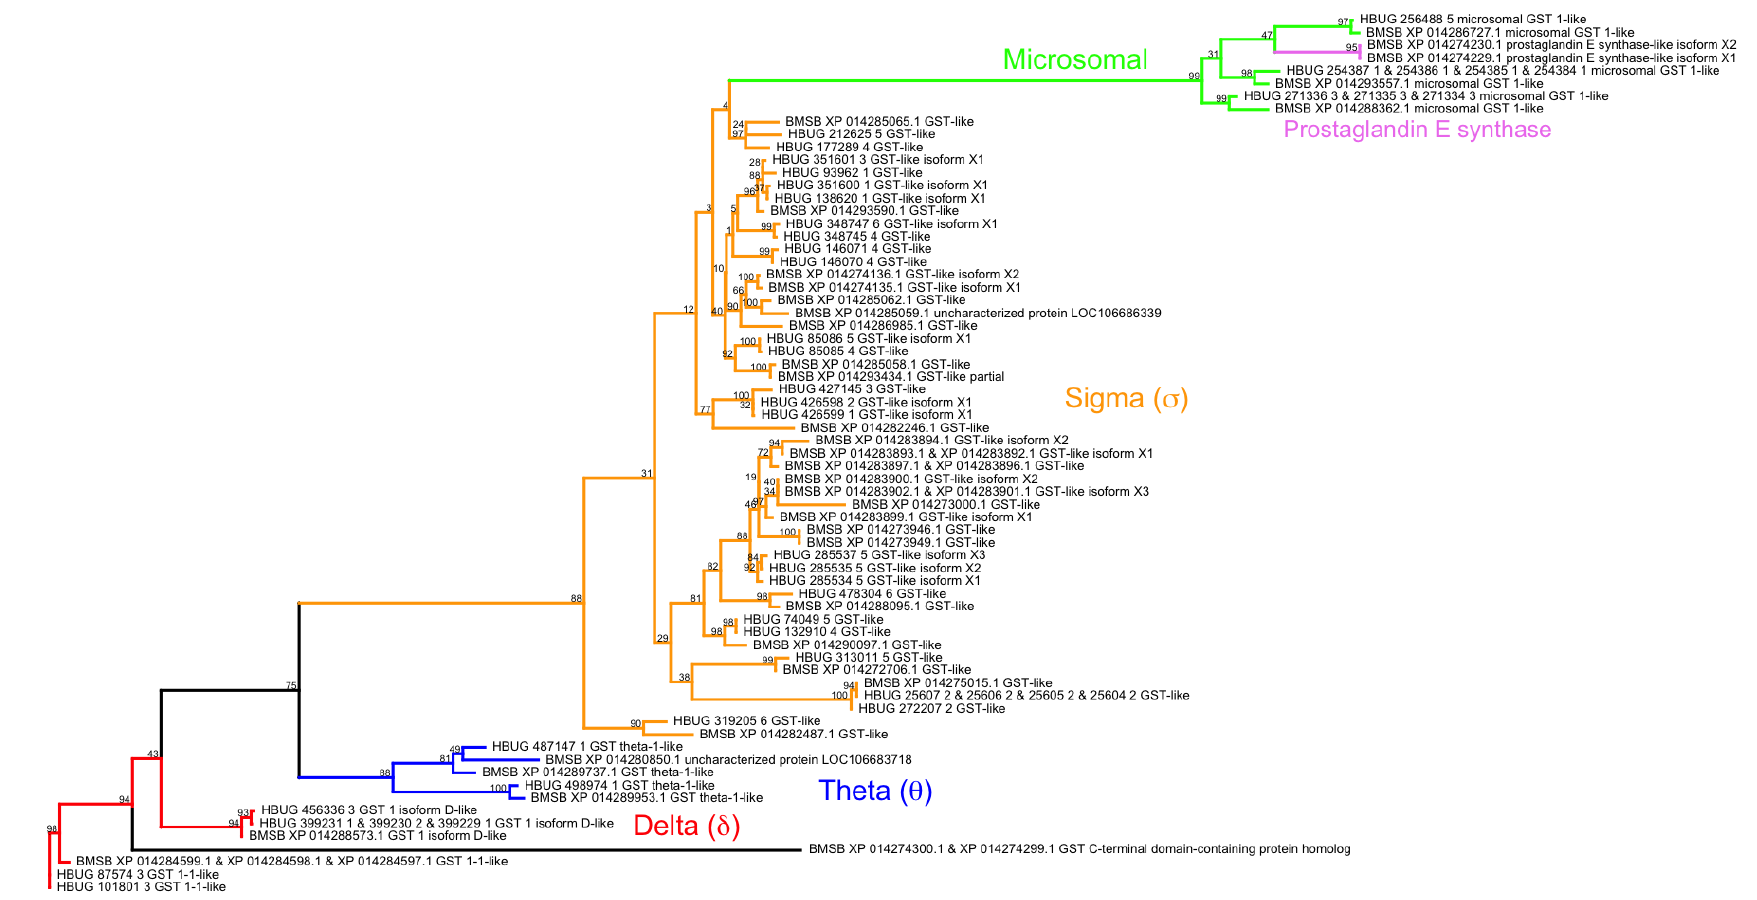
Figure 3. Maximum likelihood-based glutathione S-transferase phylogeny for H. halys and M. histrionica proteins. Four distinct clades corresponding to GST class were observed: delta (red), theta (blue), sigma (brown) and microsomal (green). Two prostaglandin E synthase isoforms (pink) were placed in the microsomal GST clade. Bootstrap support (100 replicates) is indicated on branches.